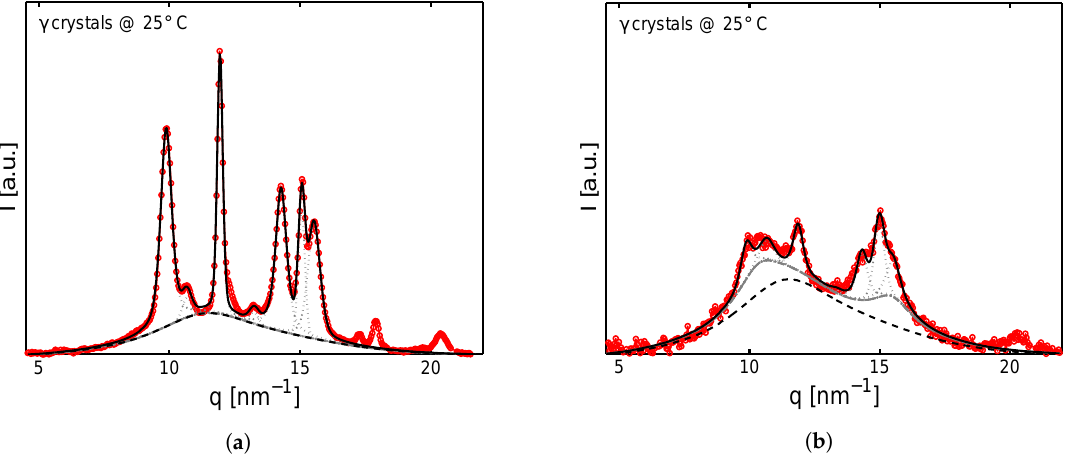
Figure 5. ( a ) An example of a deconvoluted undeformed γ -iPP sample and ( b ) a deformed γ -iPP sample, stretched at 25 ◦ C. The dashed black line is the amorphous halo, the dotted gray lines are the peak fittings, the solid gray line represents the mesophase and the solid black line is the sum of the fitted peaks. The red markers represent the radially integrated pattern obtained from the